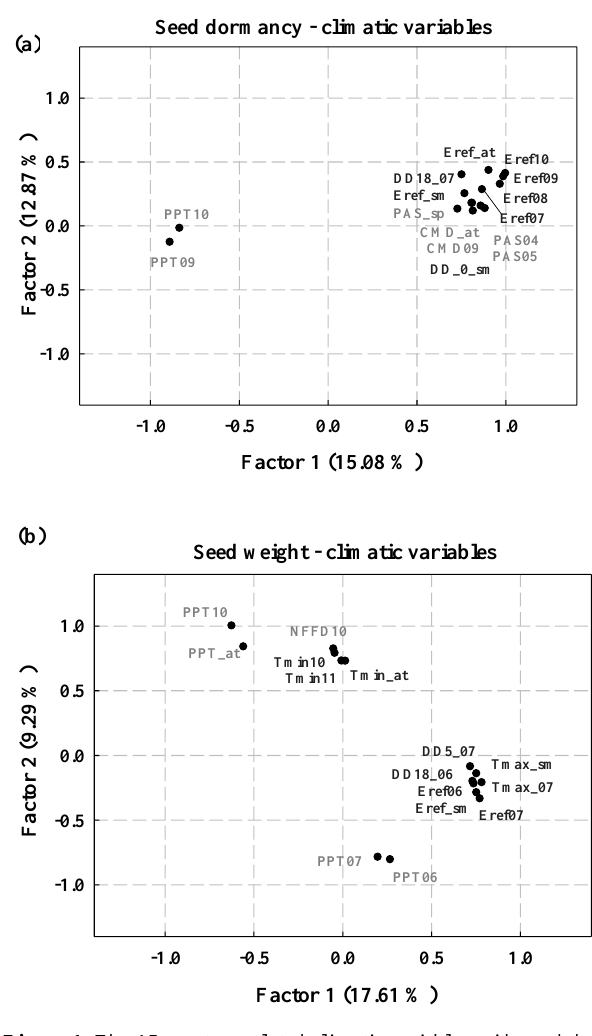
Figure 1. The 15 most correlated climatic variables with seed dor- mancy (a) and size (b) after partial least squares (PLS) regression. Note: (1) three variables ( Eref07 and _summer , and PPT10 ) were highly correlated with both seed dormancy and size; (2) fonts in black and grey represent the temperature- and precipitation-based climatic variables, respectively; (3) see Table S1 for full names of abbreviated